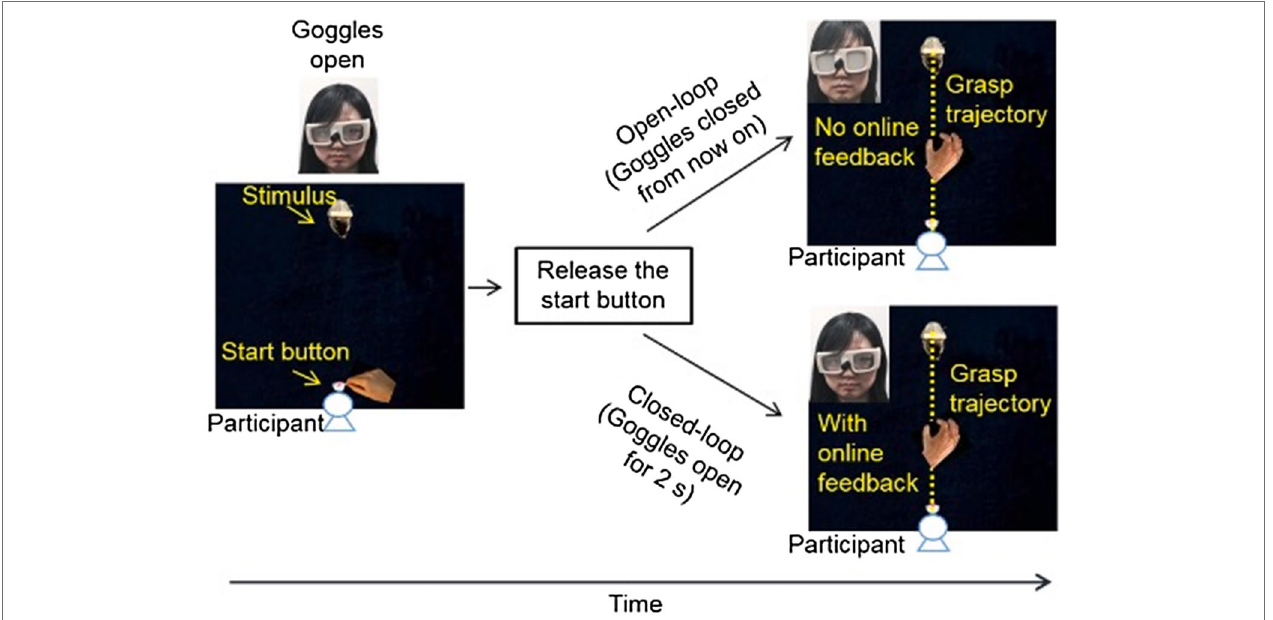
FIGURE 3 | Setup and procedure for Experiment 2. Participants first held down the start button with the thumb and index finger of their right hand. The experimenter pressed a button to open the goggles when the inducer and the target object were positioned. Participants were asked to release the start button and reach out to grasp the target object along its long side naturally and accurately as soon as the goggles were opened. In the open-loop condition, the goggles were closed as soon as the start button was released, and therefore there was no online visual feedback during the execution of grasping movement. In the closed-loop condition, the goggles were open for 2 s allowing a full view of the target object and the grasping hand during